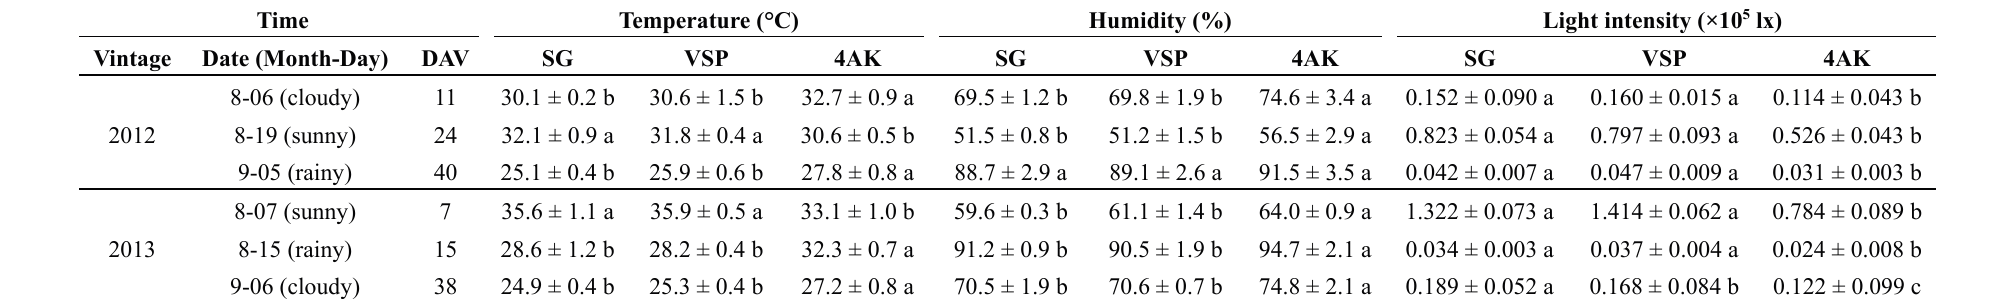
Table 1. Microclimatic data of SG, VSP and 4AK vines.